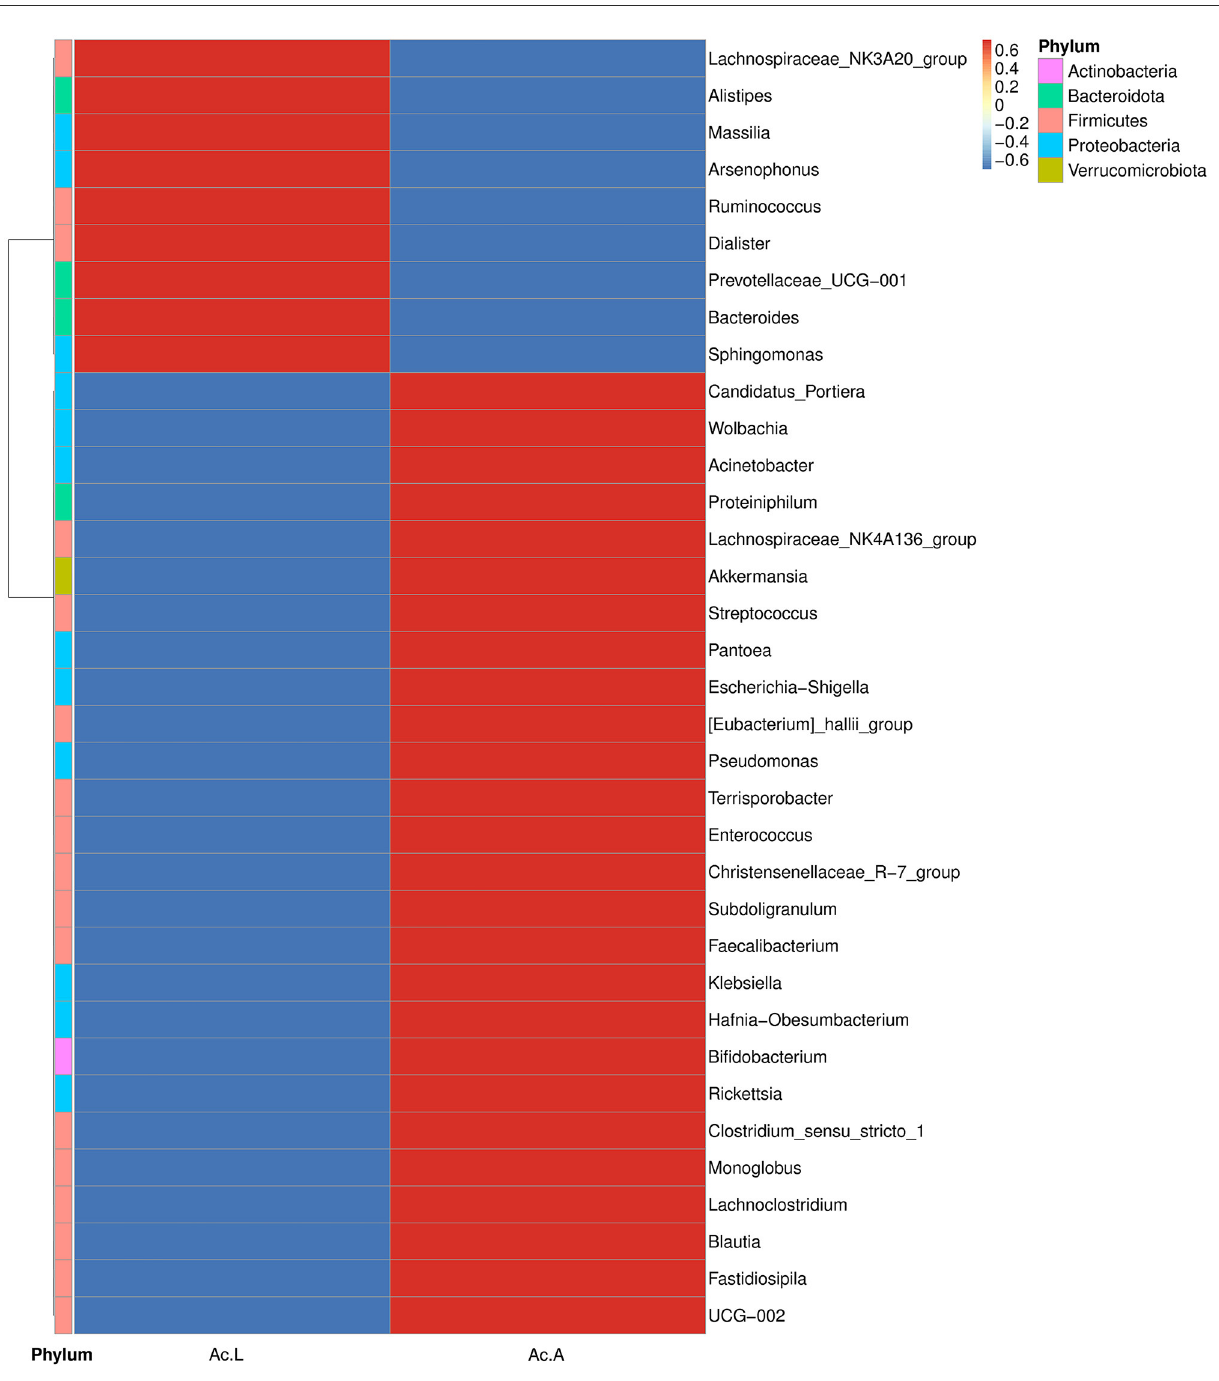
changed to 24 female and 14 male (F: M = 1.71:1) insects when the symbiont was suppressed. The offspring of both sexes dropped significantly, and an obvious disequilibrium toward the dominance of females (1.71:1) happened after the symbiont was suppressed. These observations suggested that the males are more susceptible to antibiotic treatment than the females.